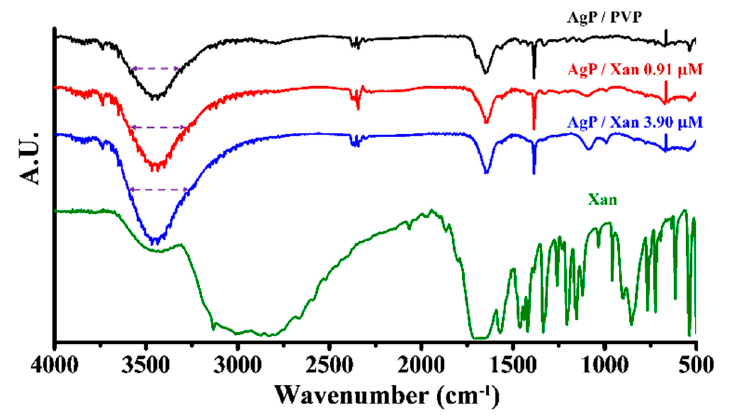
Figure 4. FTIR spectra of AgP / PVP, AgP with Xan added (AgP / Xan 0.91 µ M, and AgP / Xan 3.90 µ M), and free Xan.